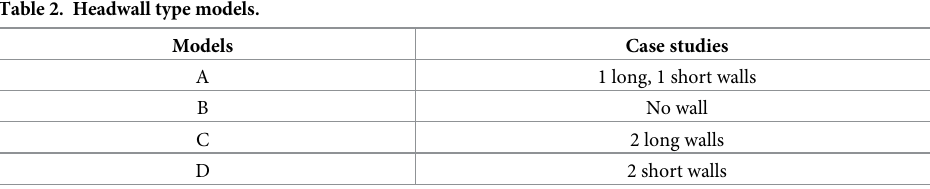
Table 2. Headwall type models.